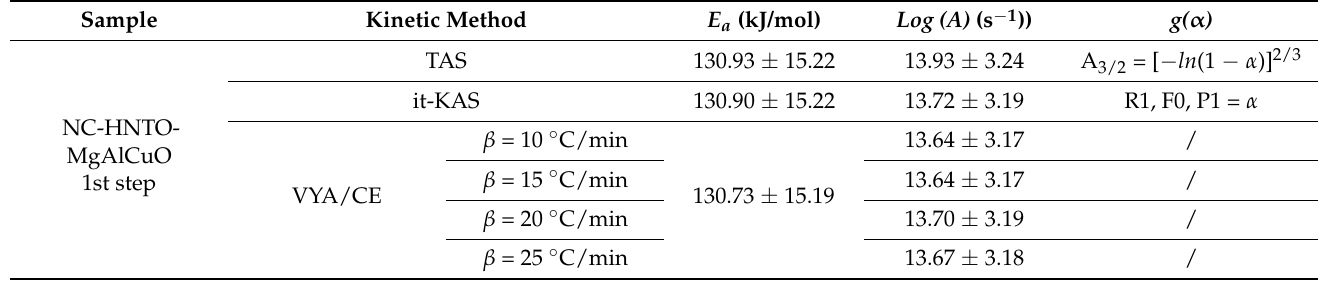
Table 2. Thermo-kinetic parameters of the developed energetic